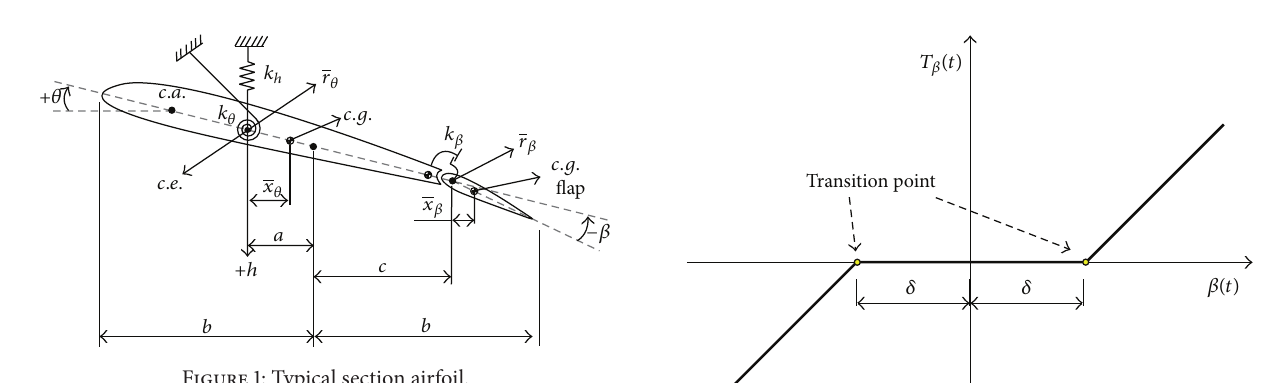
Figure 1: Typical section airfoil.